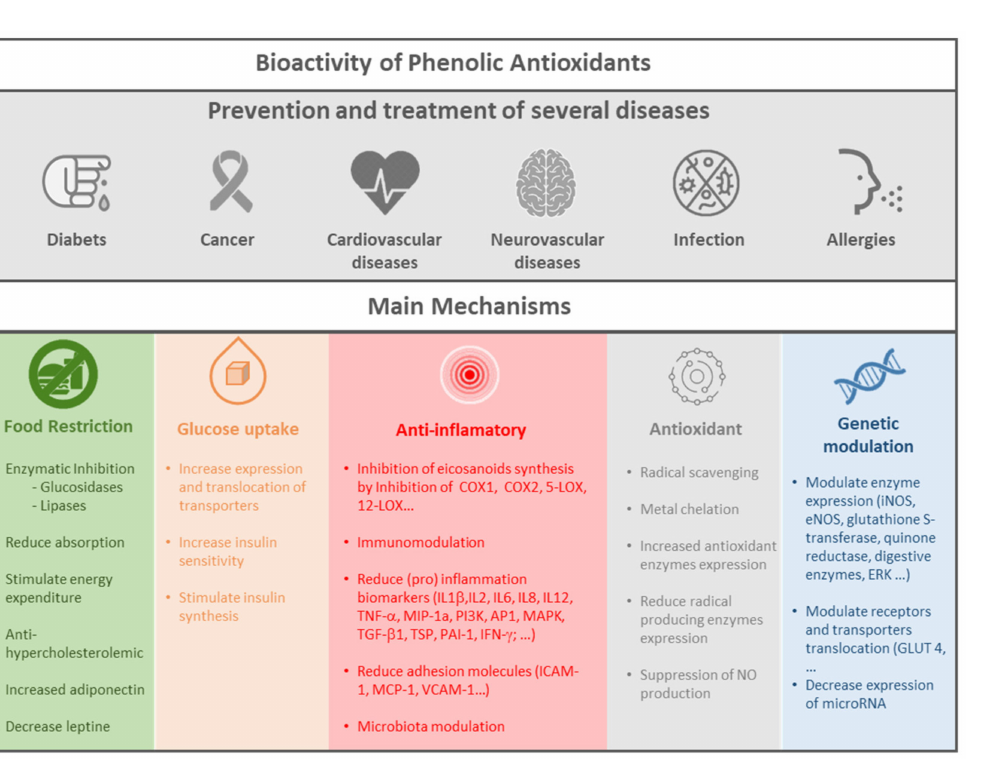
Figure 3. The bioactivity of phenolic antioxidants and some of their main mechanisms of action. Cyclooxygenase (COX), lipoxygenase (LOX), intracellular adhesion molecule-1 (ICAM-1), monocyte chemoattractant protein-1 (MCP-1), vascular cellular adhesion molecule-1 (VCAM-1), inducible nitric oxide synthase (iNOS), endothelial nitric oxide synthase (eNOS); tumor necrosis factor- α (TNF- α ); extracellular signal regulated protein kinase (ERK); interleukin (IL), phosphoinositide 3-kinase (PI3K); transforming growth factor- β (TGF- β